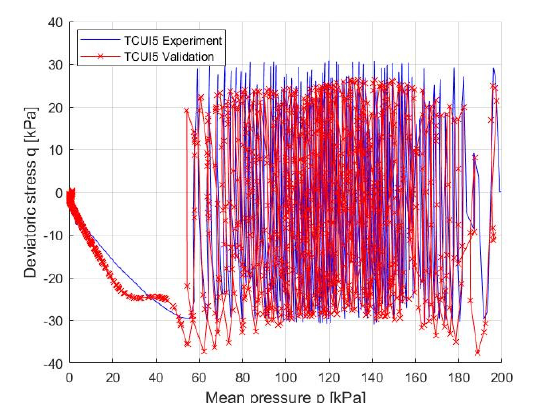
Fig. 6 Effective stress paths in undrained cyclic tests with isotropic initial stresses and stress cycles performed on loose specimens ( I D0 = 0.26 and p 0 =200 kPa).